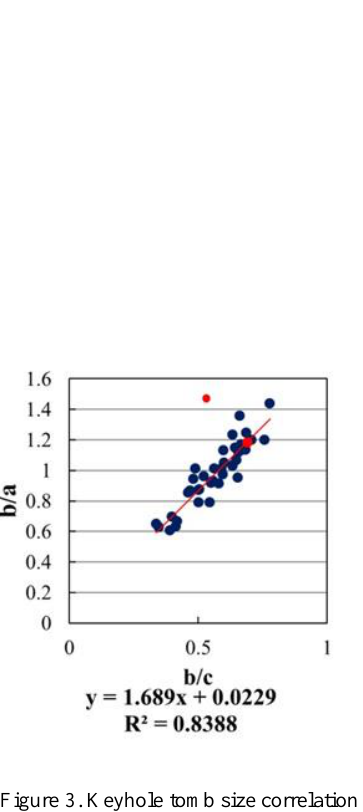
Figure 1. Three tombs: Nintoku, Hashihaka and Akamura